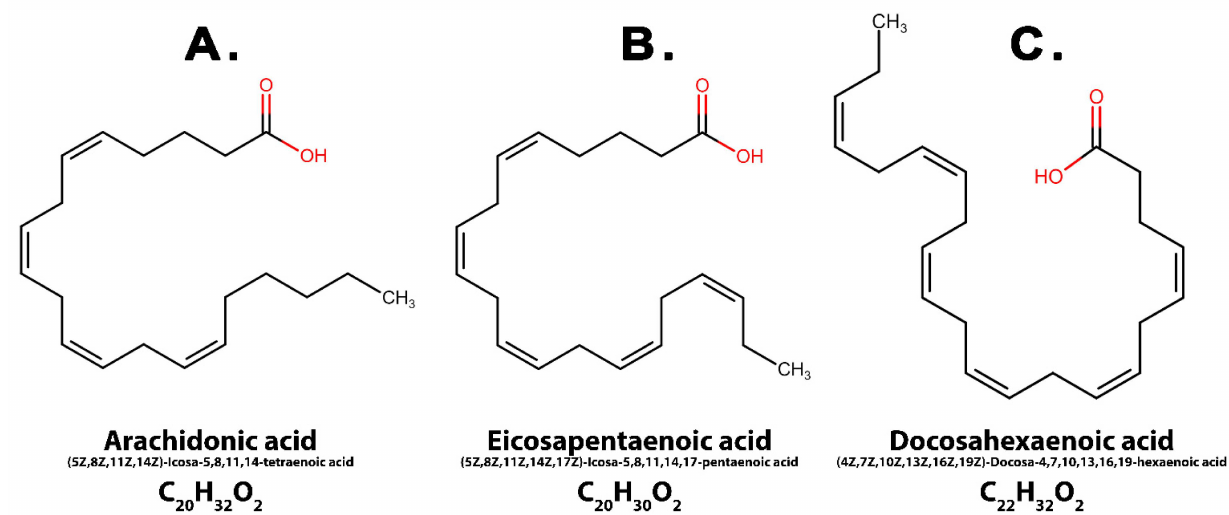
Figure 1. Fatty-acids’ chemical